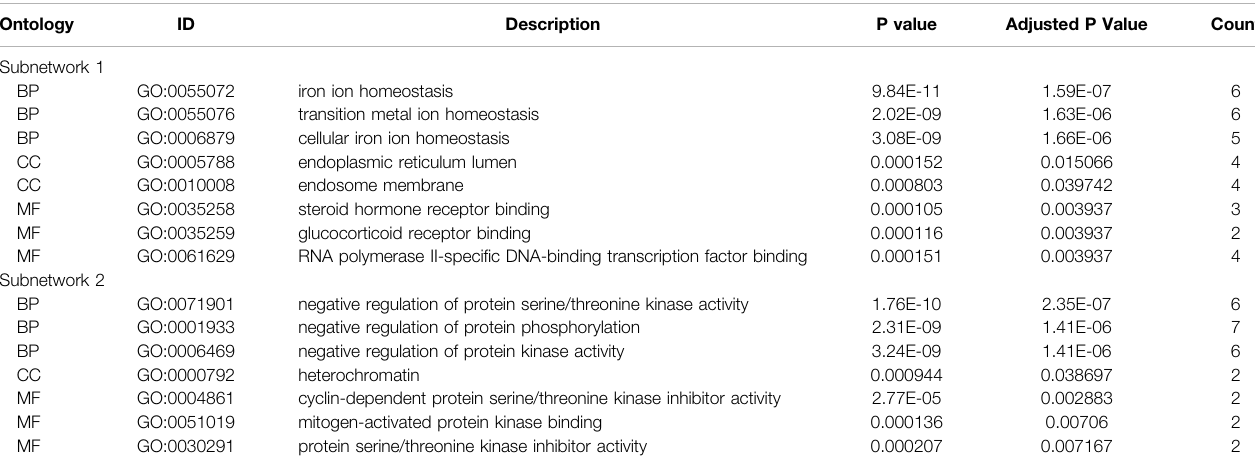
TABLE 2 | The GO function enrichment analysis of the two most signi fi cant MCODE